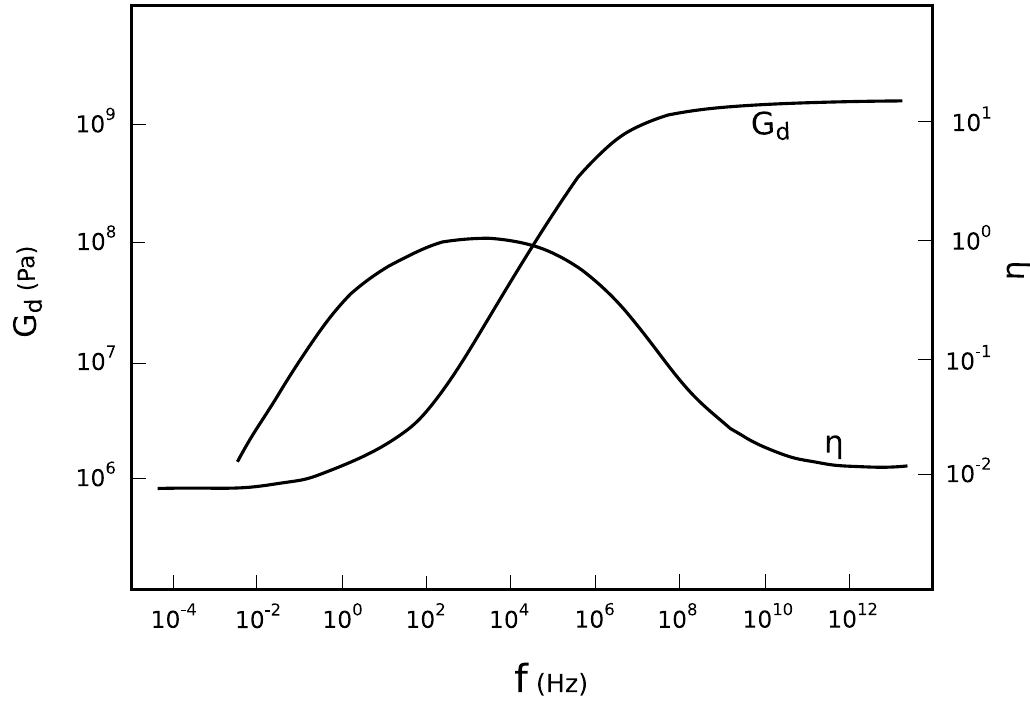
Figure 2. Shear dynamic properties of damping material EAR